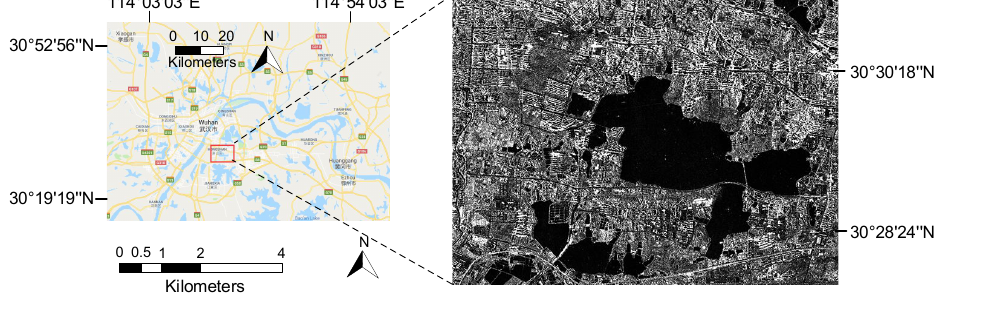
Figure 6. SAR image of Data Set 1.